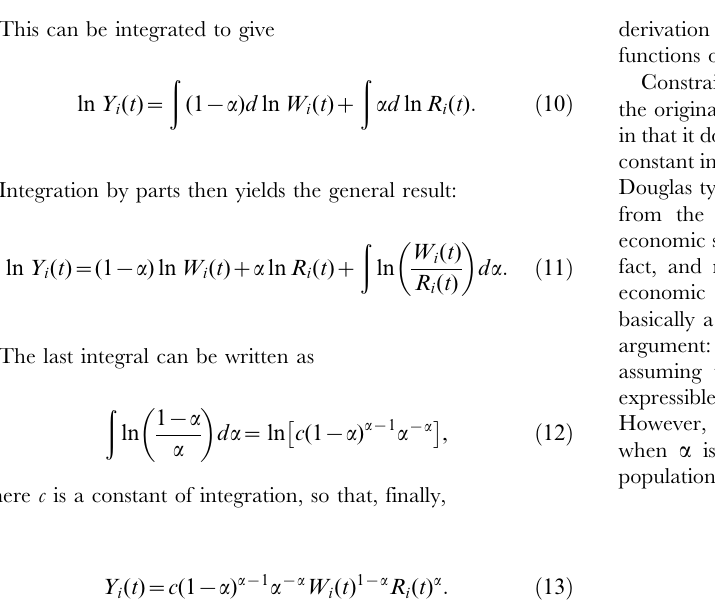
Figure 2. Residuals from regressing ln(total wages) on ln(population) using data for all 943 urban areas of the United States smoothed over the 2009–2011 period.